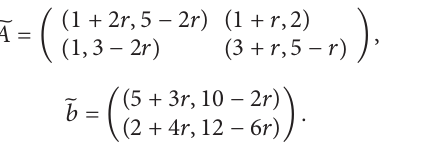
̃𝑏 (−) and the value of the first row for ̃𝑥 −,𝑙,𝑢 2